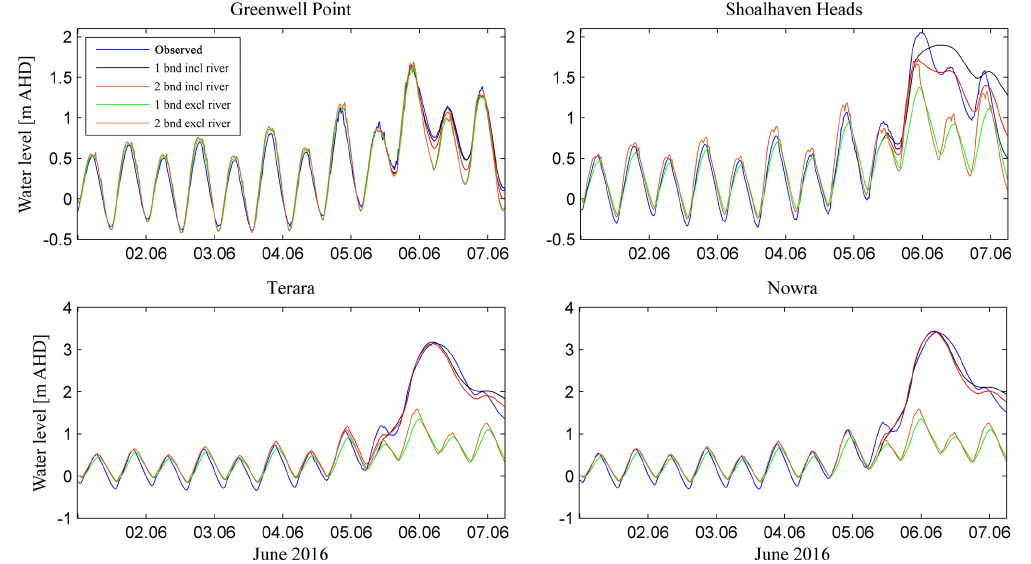
Figure 9. Modelled and observed water levels for different model boundary forcing and entrance conditions.